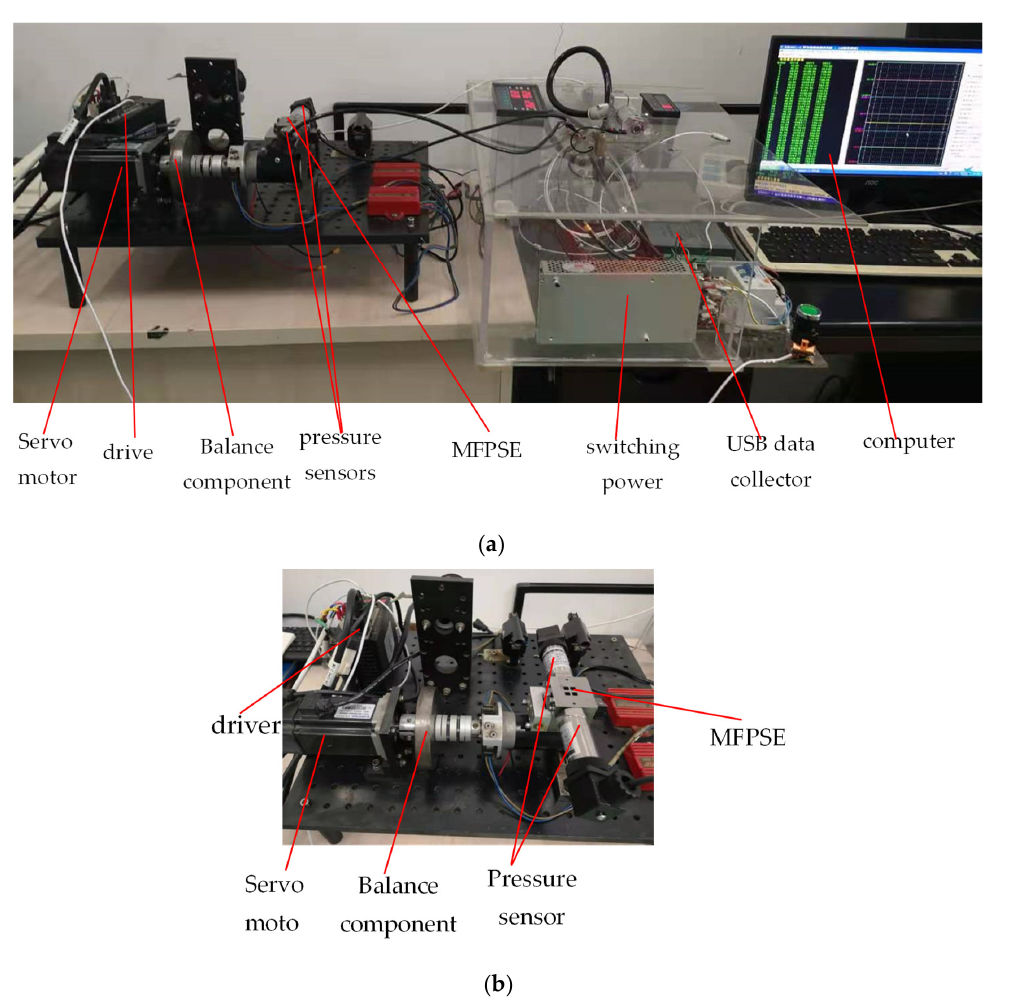
Figure 3. Experimental test workbench for MFPSE: ( a ) whole test workbench; ( b ) mechanical test components of MFPSE.